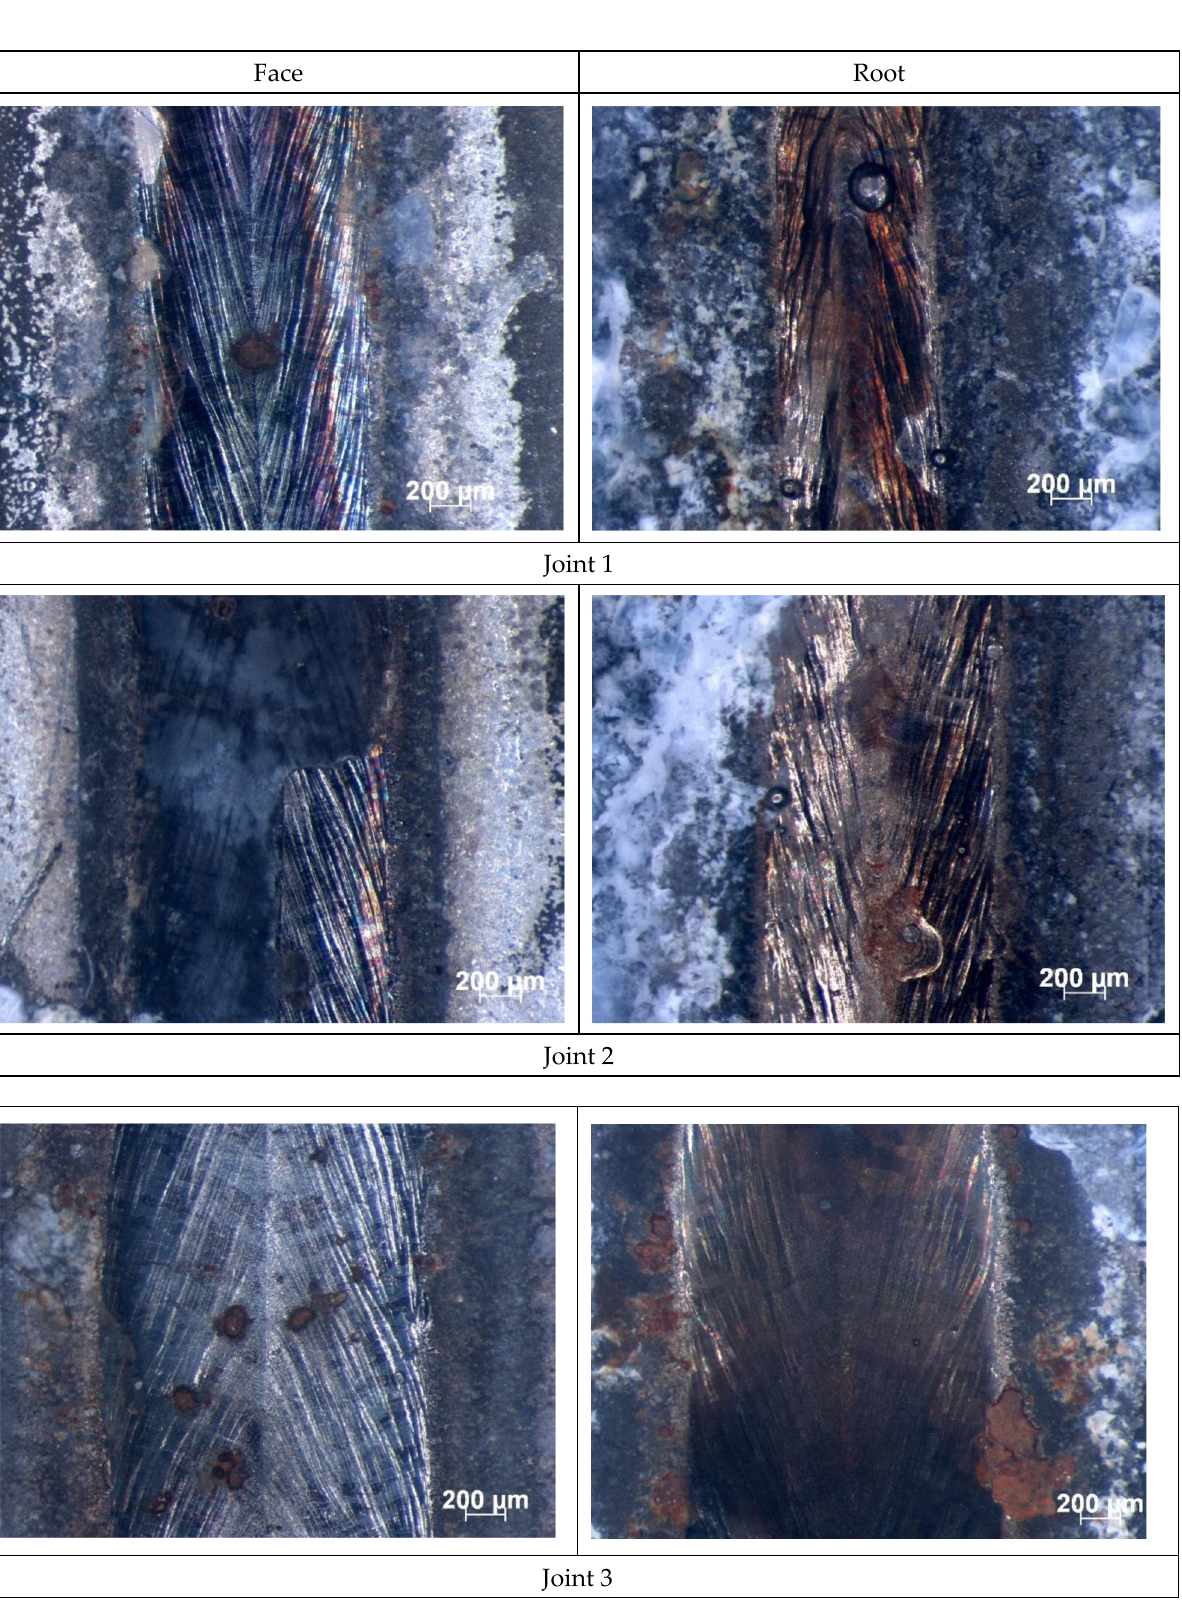
Figure 9. Surface of welded joints after corrosion tests in 5% NaCl solution.